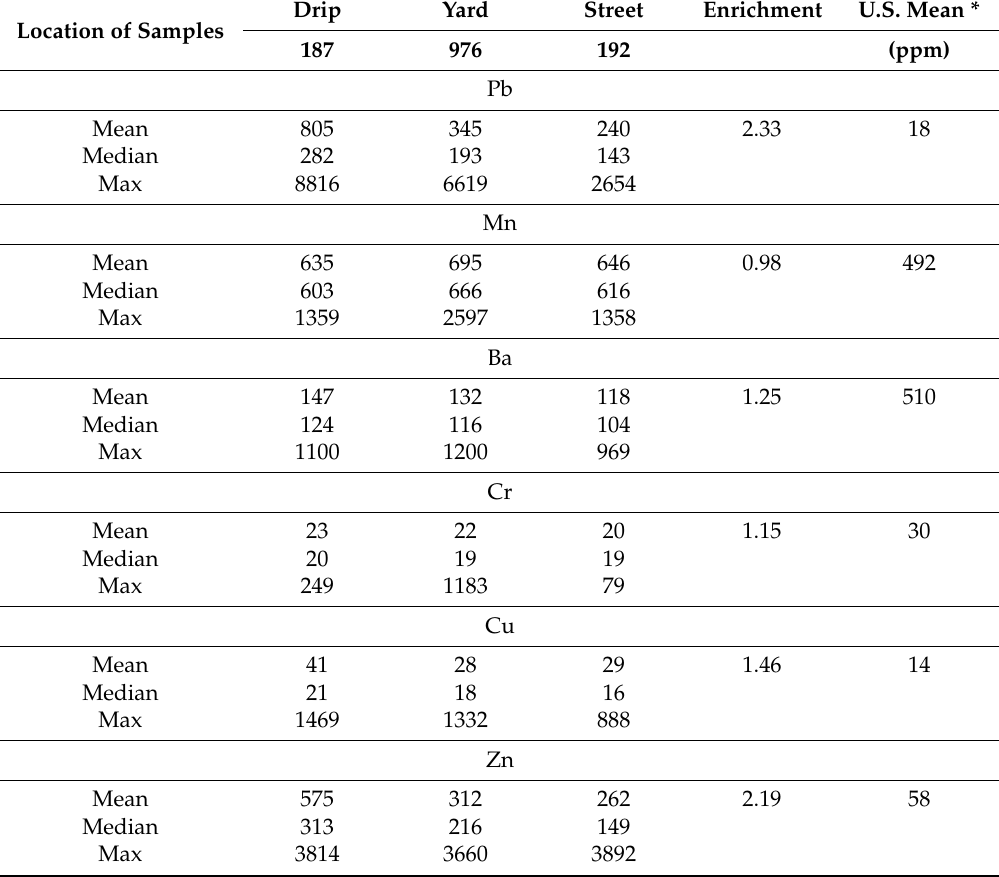
Table 1. Metals concentrations (ppm) for soils as a function of location on a property. Enrichment factor is calculated as highest value/lowest value for each mean metal concentration. Lead (Pb), manganese (Mn), barium (Ba), chromium (Cr), copper (Cu), and zinc